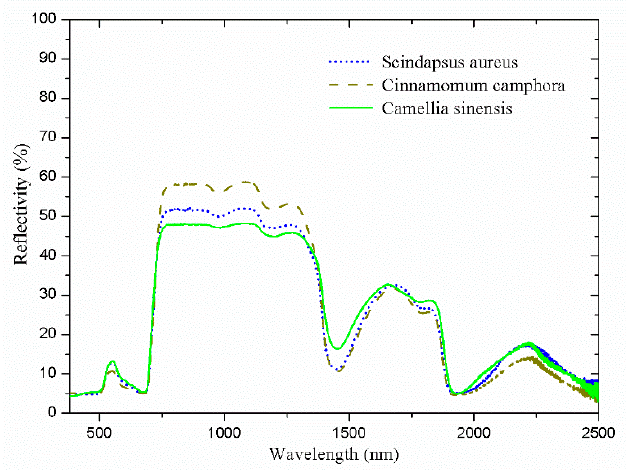
Figure 1. Solar spectral reflectance of Scindapsus aureus , Cinnamomum camphora , and Camellia sinen- sis leaves.